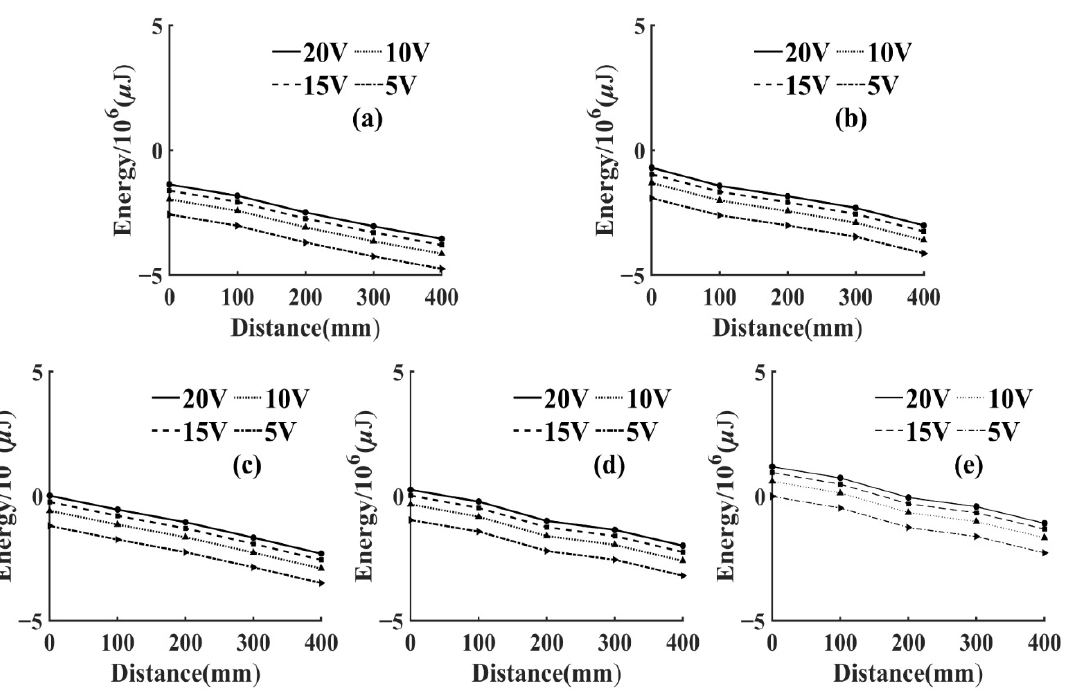
Figure 6. Variation of AE signal energy with propagation distance for T1 specimen. ( a ) Pulse fre-